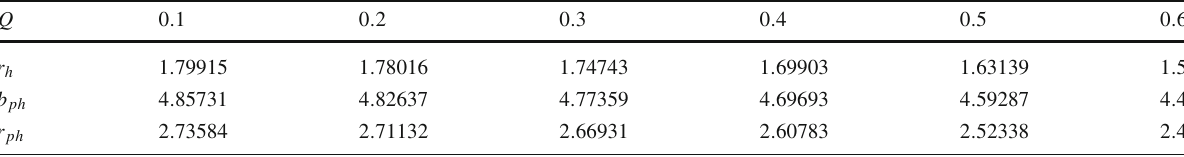
Table 3 The numerical values of r h , b ph , and r ph , for some specific values of Q with φ = 0 . 01, λ = 0 . 1 and M = 1 Q 0 . 1 0 .